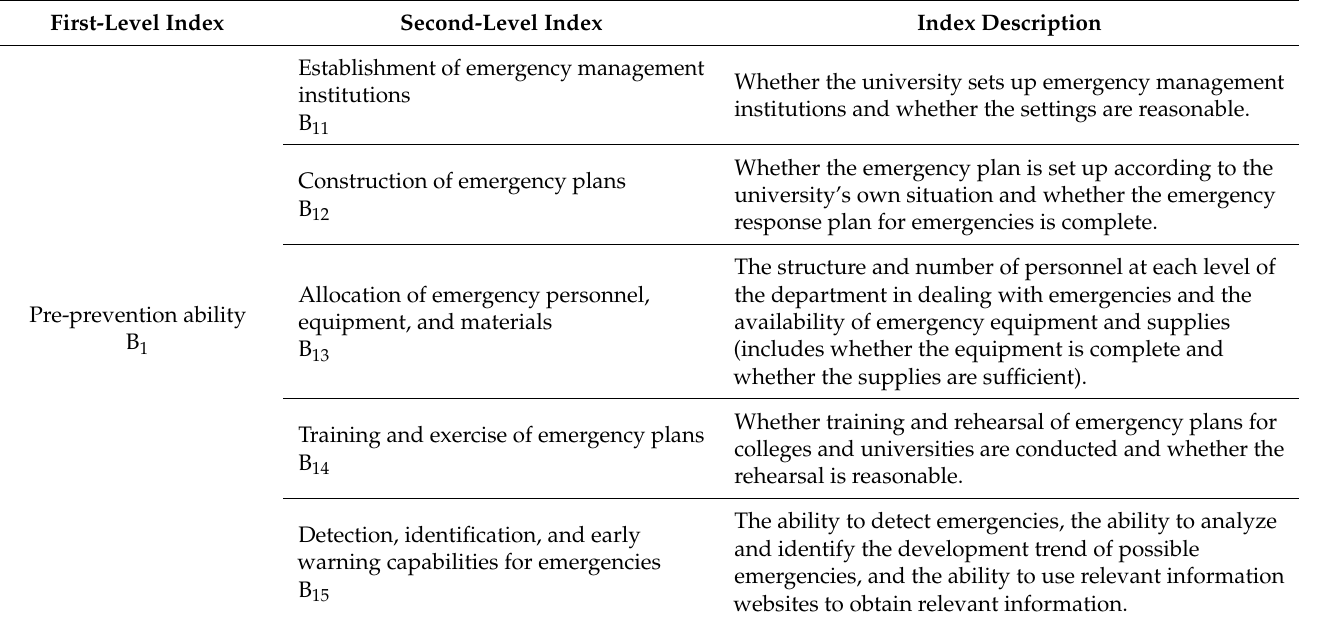
Table 1. Index system of campus emergency management